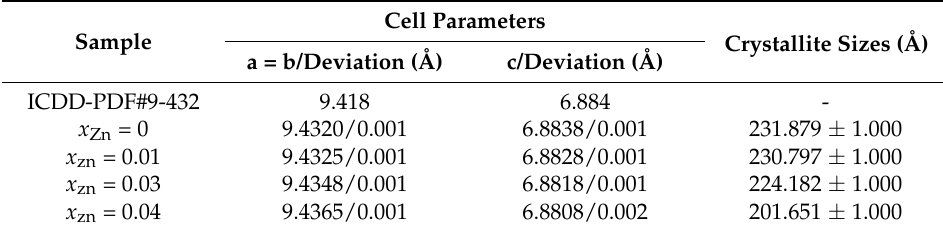
Table 1. Calculated lattice constants, the deviation of Zn:HAp and the average crystallite sizes measured parallel and perpendicular to the c axis with different x Zn values.